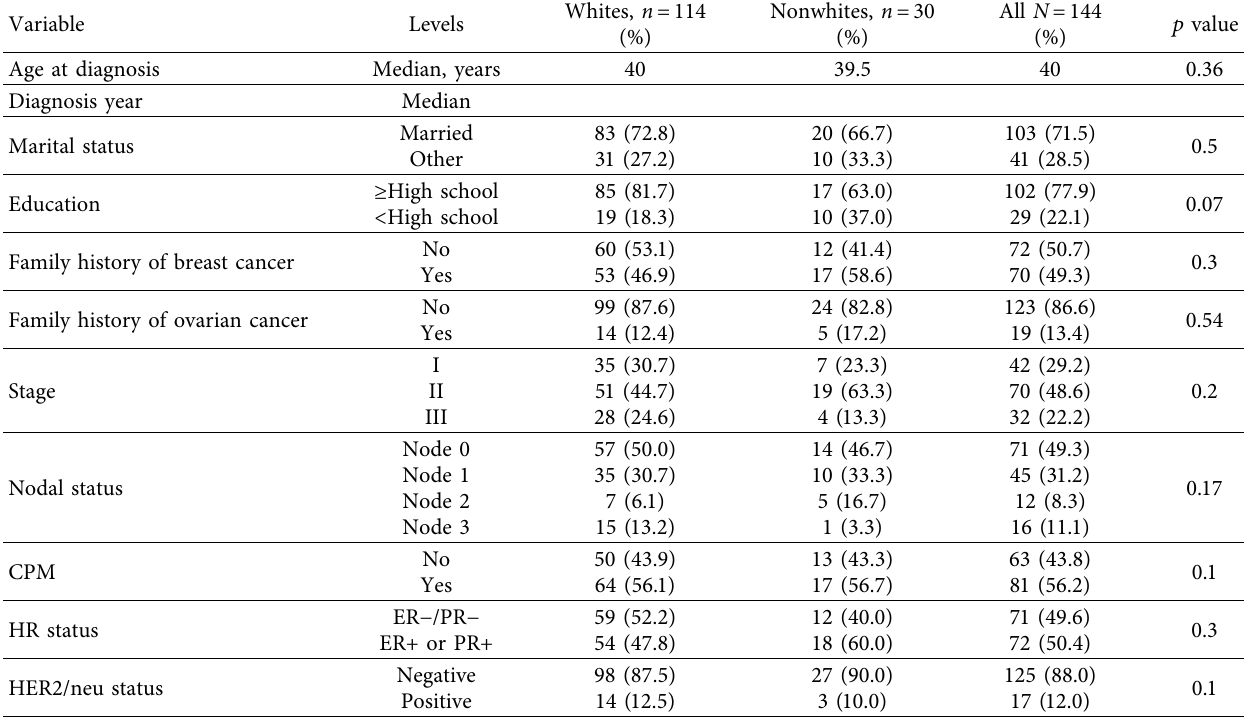
Table 1: Patient characteristics by race/ethnicity ( N � 144).